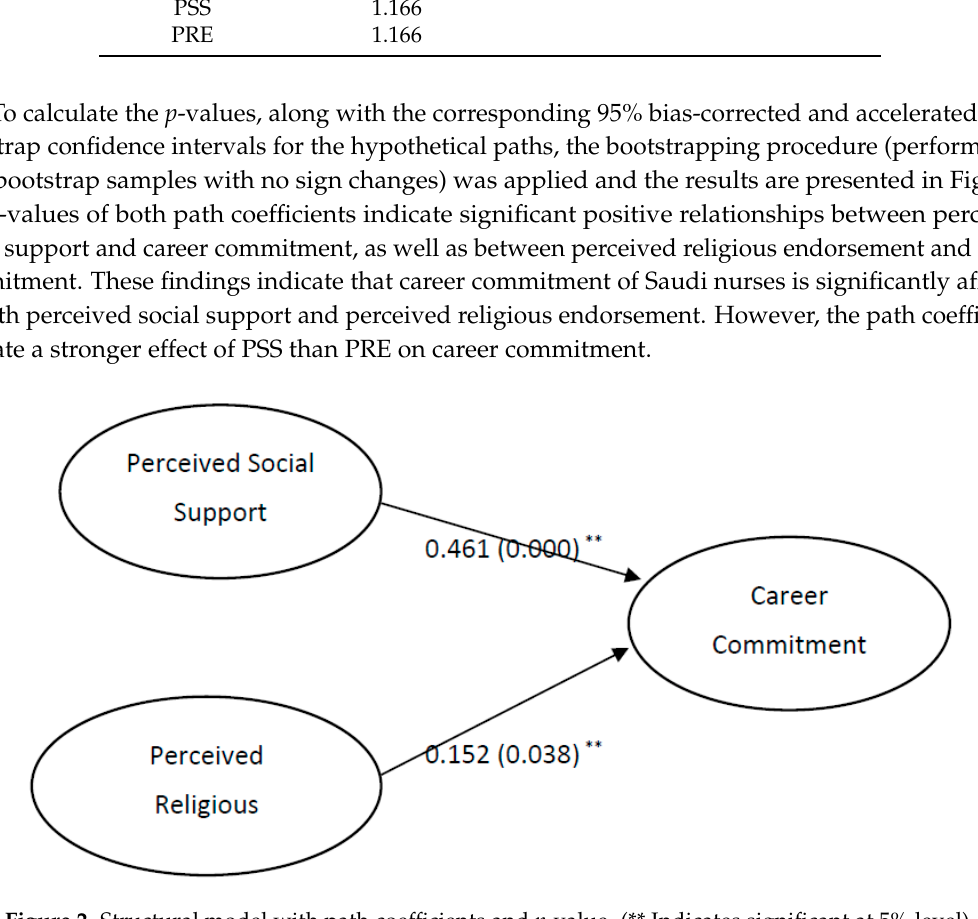
Figure 2. Structural model with path coefficients and p -value. (** Indicates significant at 5% level).